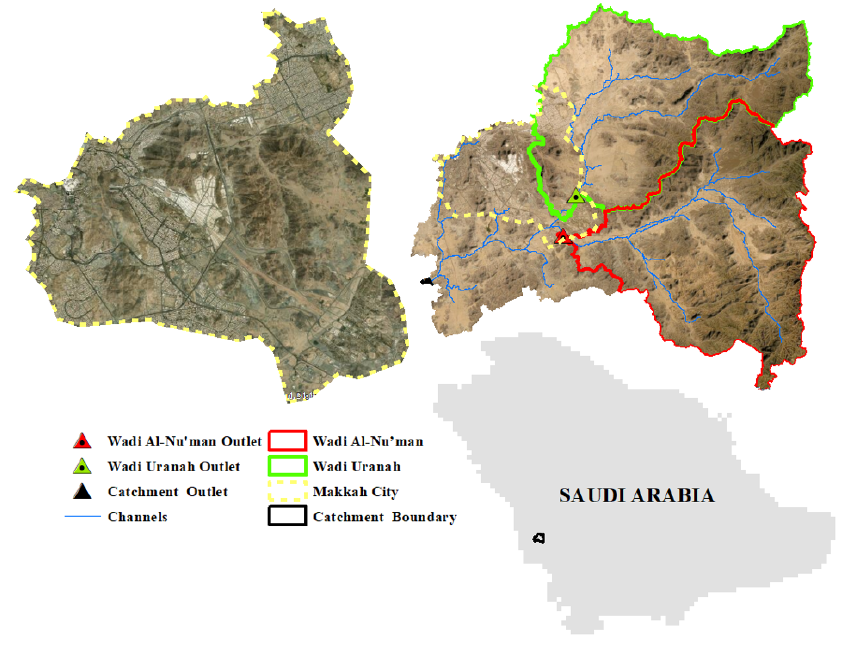
Figure 1. Makkah Figure 1. Makkah watershed.